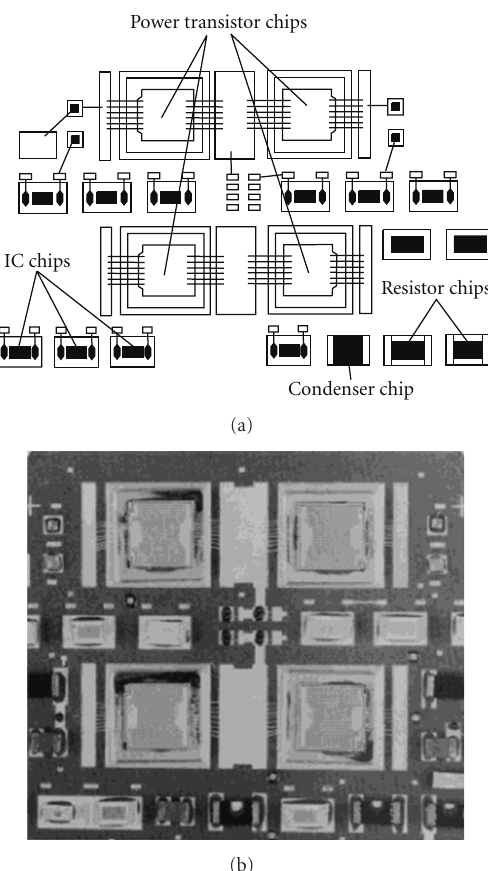
Figure 1: (a)Power-transistor layout. (b)Power transistors